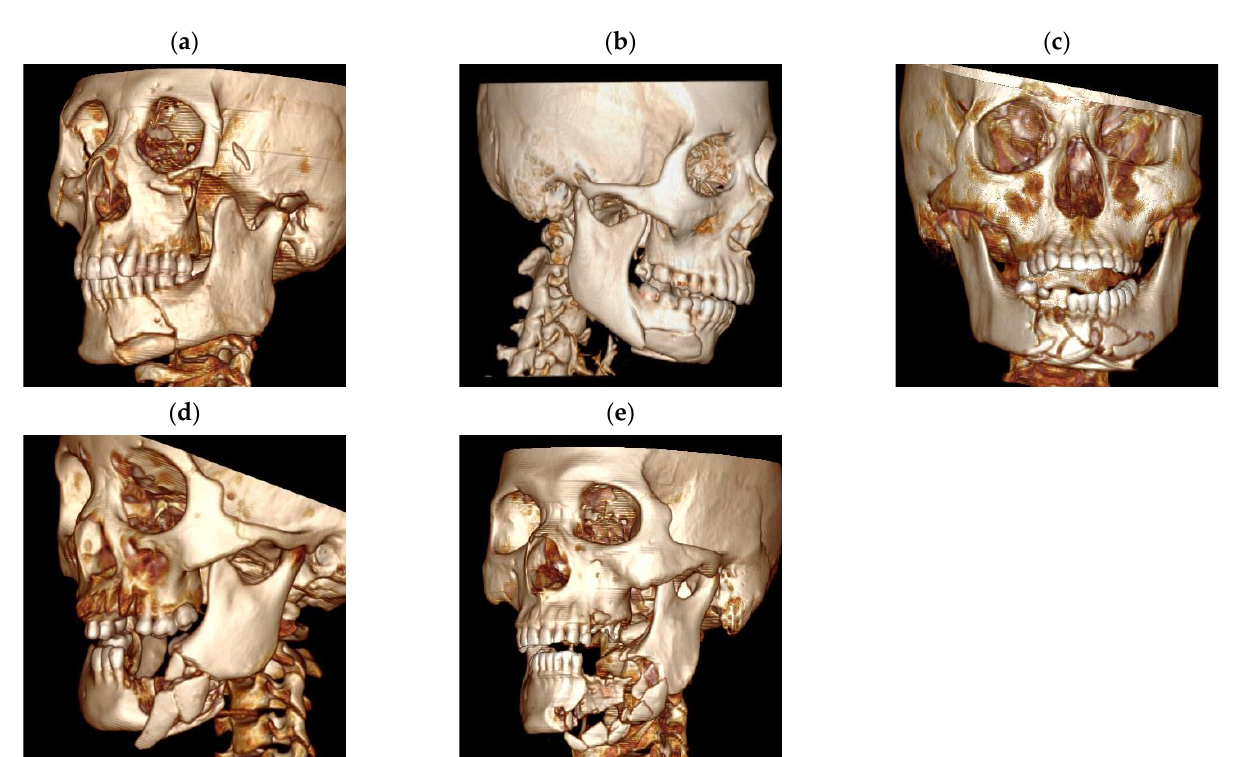
Figure 1. 3DCT reconstruction of the OCCS classification of CMFs. ( a ) type I; ( b ) type II; ( c ) type III; ( d ) type IV; ( e ) type V; 3DCT: three-dimensional computed tomography; CMFs: comminuted man- dibular